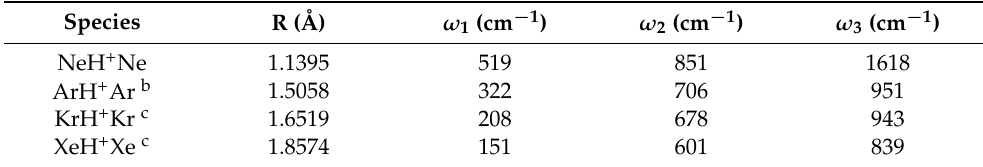
Table 3. CCSD(T)/aug-cc-pVTZ a structural parameter and harmonic vibrational frequencies for Ng 2 H + .